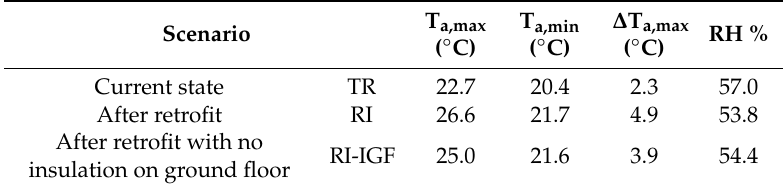
Table 8. Maximum and minimum values of air temperature, maximum amplitude of temperature, and relative humidity of the three investigated scenarios during the period 5–14